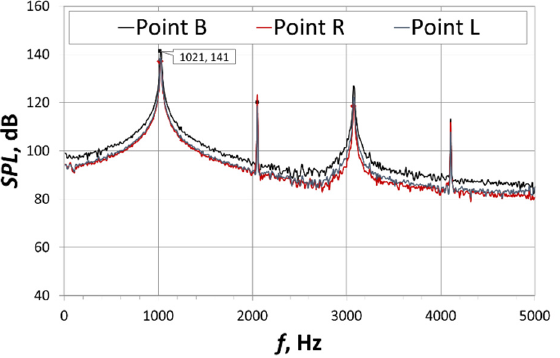
Figure 9. Spectral analysis of SPL for velocity equal to 40 m/s—CFD.